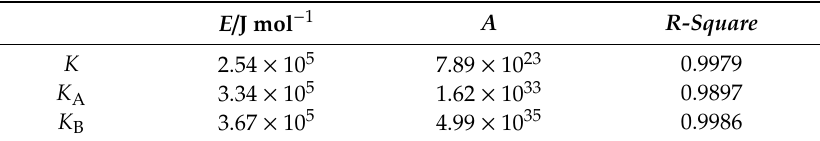
Table 4. Arrhenius equation fitting